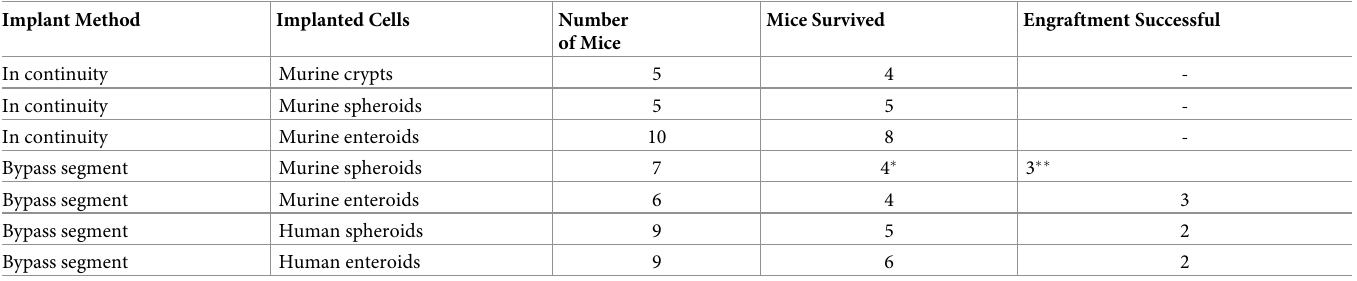
Table 1. Synopsis of all implantation experiments. All surviving recipient mice were sacrificed and examined on postoperative day 7 except two mice implanted with spheroids that were sacrificed and examined after 28 days (see